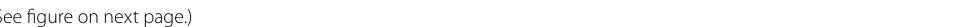
70 km, M w 5.5) that occurred along the Tonga–Kermadec trench during the period 1 ≤ ≥